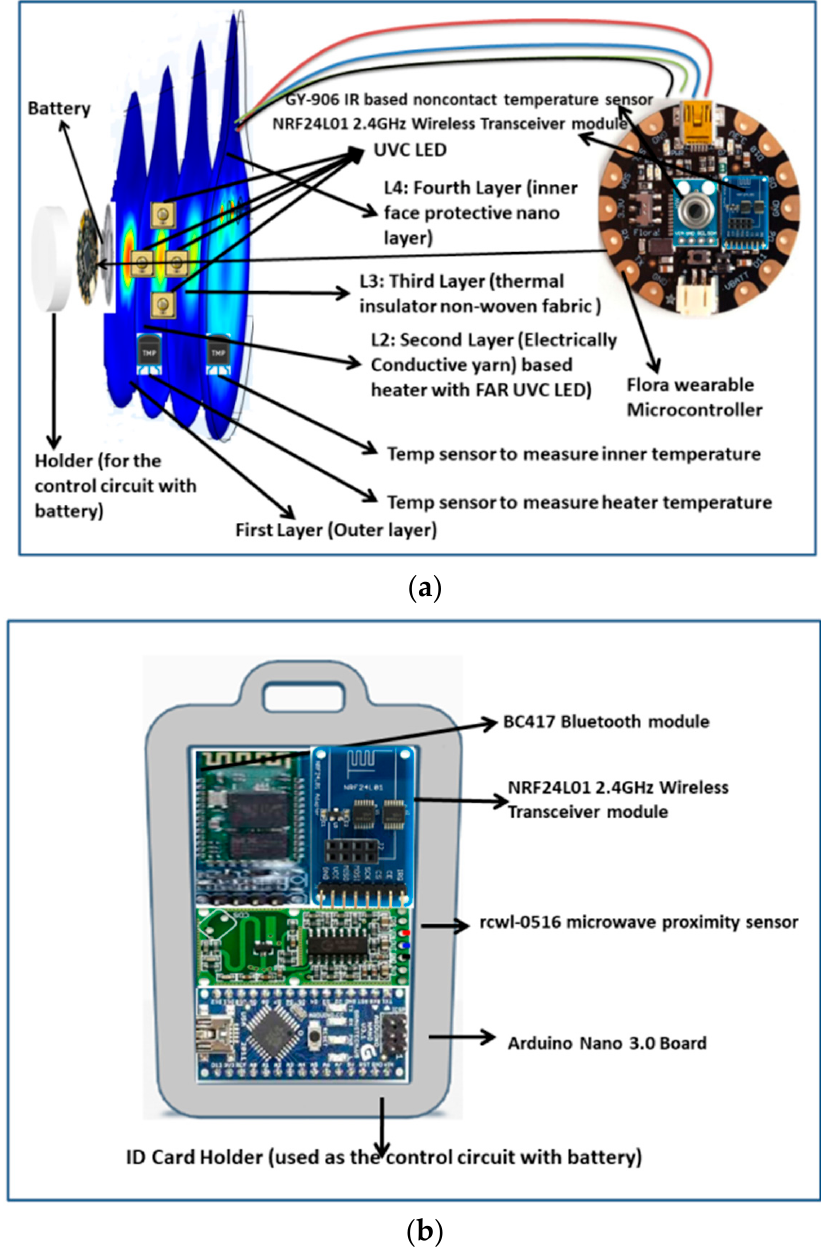
Figure 1. ( a ) Overall structure of the germicidal face mask for airborne virus; ( b ) identity card-based face mask control device .